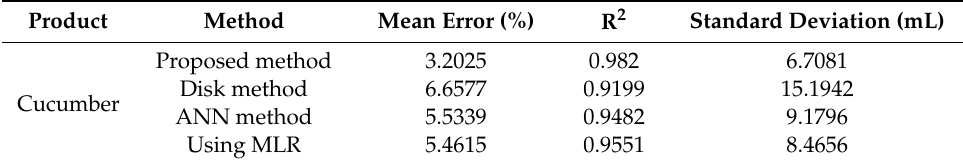
Table 8. Comparison between our proposed method and other methods on the cucumber dataset.